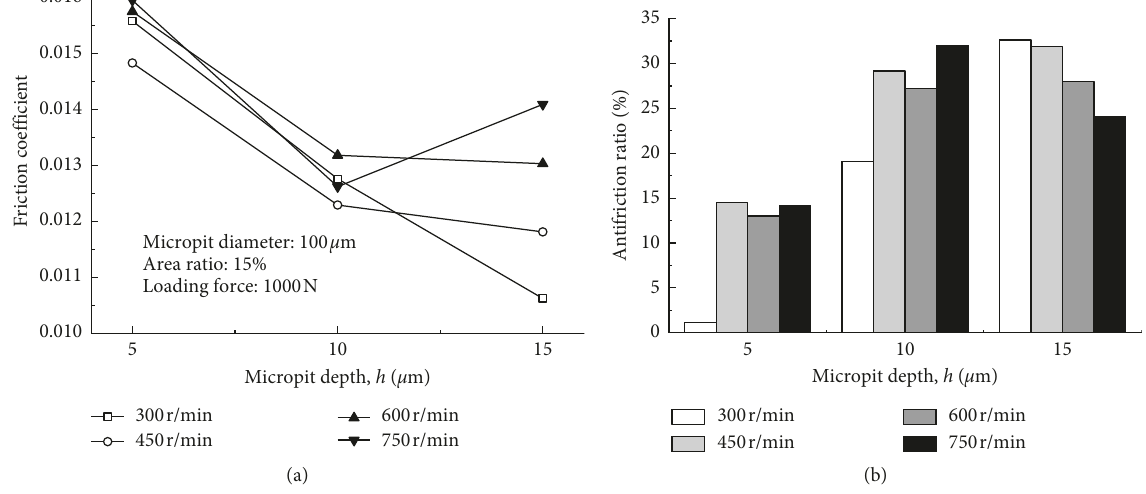
Figure 5: (a) Friction coefficient and (b) antifriction ratio when the value of the area ratio is